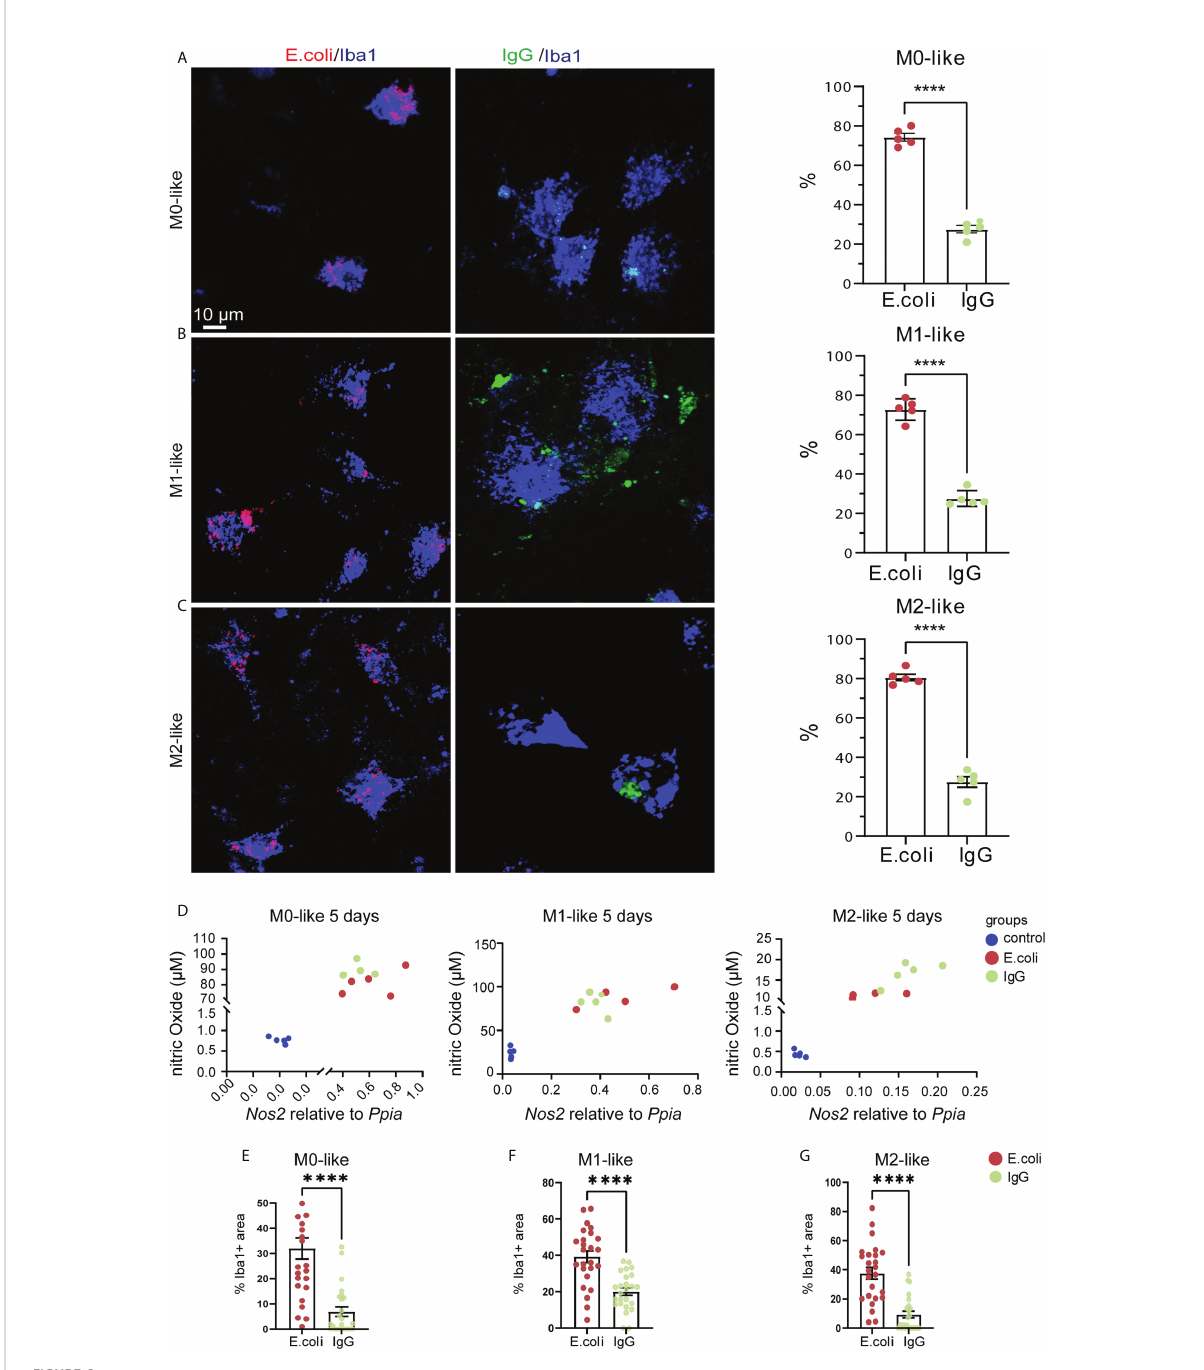
FIGURE 6 Microglia subtypes show M1-like features after prolonged phagocytosis substrate exposure (A – C) Confocal images showing anti-Iba1 immunostaining of M0-, M1- or M2-like microglia subtypes along with rhodamine-E.coli particles (red, E.coli) or IgG-FITC beads (green, IgG) after 5 days of phagocytosis substrate exposure. Histograms showing percentage of microglia with internalized E.coli particles or IgG beads. Microglia subtypes showed phagocytosis preference for E.coli particles rather than IgG beads. (D) Scatter plots showing similar correlation (non- parametric Spearman correlation) between NO levels and Nos2 gene expression for M0- (r = 0.6536, p=0.0099), M1- (r = 0.8214, p = 0.0003), and M2-like (r = 0.8857, p < 0.0001) microglia. Ppia was used as a reference gene. (E – G) Co-localization analyses showing the relative occupancy of Iba1 immunostained cell areas by E.coli particles or IgG beads. Microglia subtypes showed phagocytosis preference for E.coli particles rather than IgG beads. Data are expressed as mean ± SEM from 5 independent biological replicates (A – C) or 4-6 cells from each of 5 independent biological replicate (D) . Data are means ± SEM. ****p < 0.0001, ns, not signi fi cant, Student ’ s